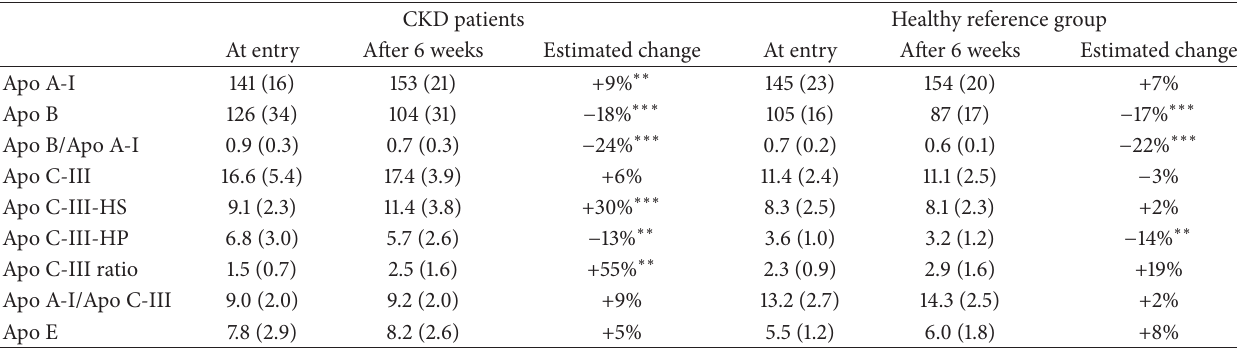
Table 3: Plasma apolipoprotein concentrations levels (mg/dL) in patients with chronic renal insufficiency ( n = 23) and healthy reference subjects ( n = 17) at start and end of treatment with 1mg tesaglitazar o.d. Mean, standard deviation, and 95% confidence interval (in parenthesis).